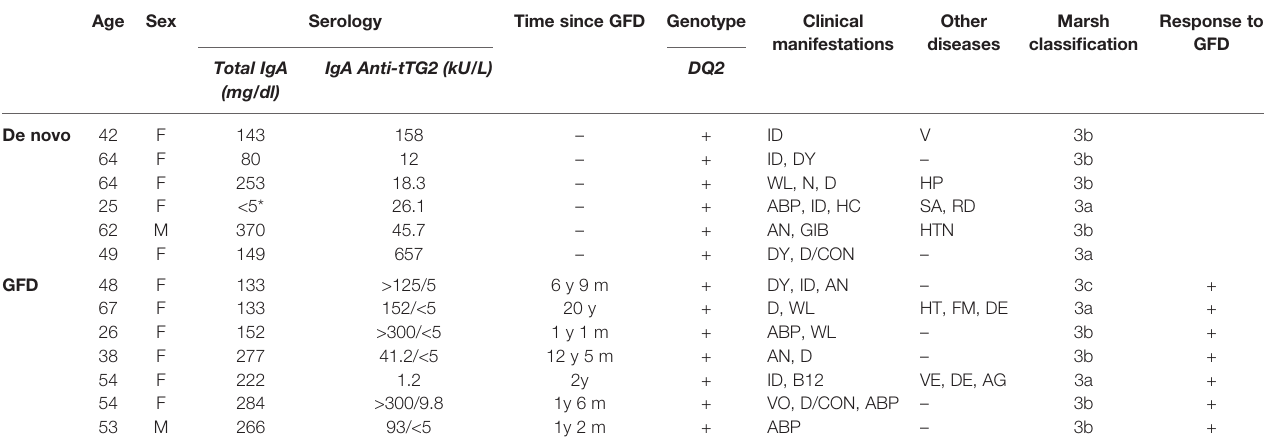
TABLE 1 | Detailed information on study celiac disease